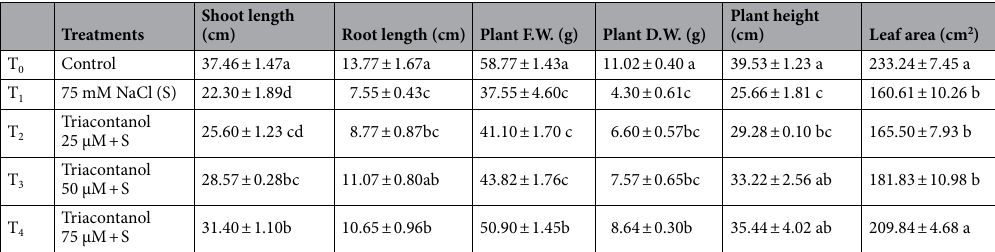
Table 1. Effect of triacontanol spray on morphological characters of hot pepper plants under salt stress. Means sharing the same letter for a parameter, do not differ significantly at p ≤ 0.05; F.W. = Fresh Weight; D.W. Dry weight.